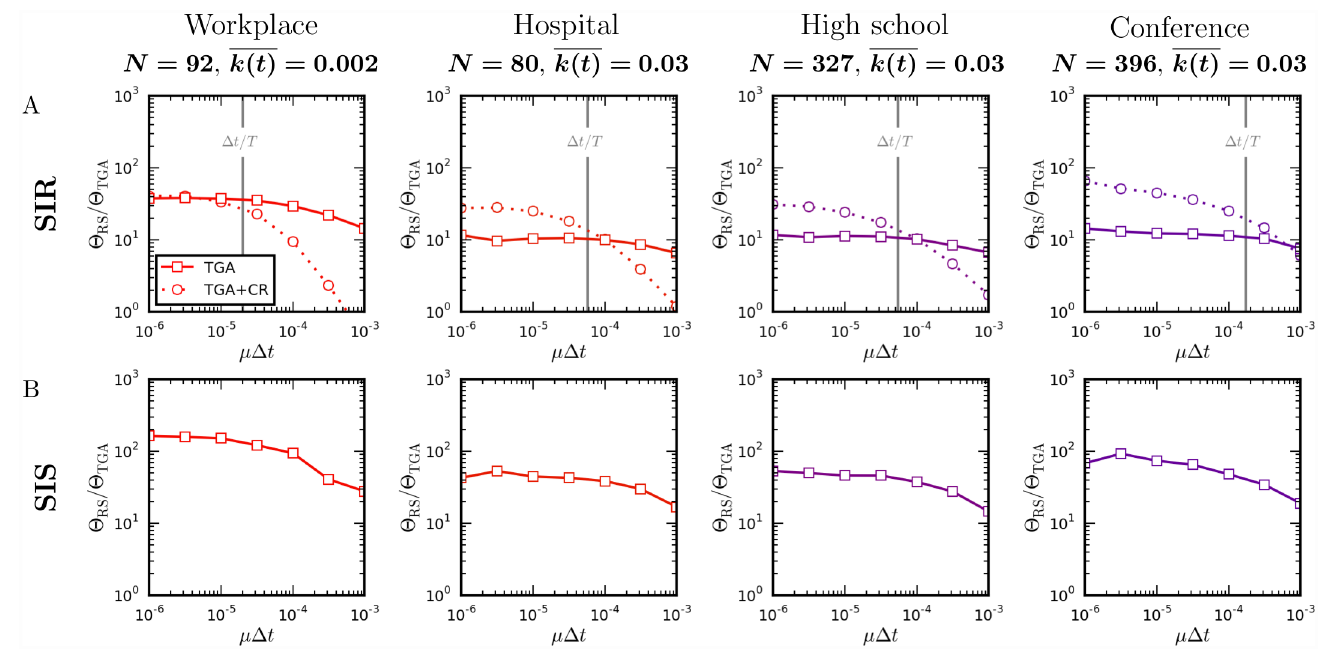
Fig 5. Comparison of the speed of the temporal Gillespie and rejection sampling algorithms on empirical time-varying networks. Ratio Θ RS / Θ TGA between the time per realization of a single simulation using rejection sampling and the temporal Gillespie algorithm on empirical face-to-face contact networks in different social settings (Table 1): (A) for a SIR process, without (TGA) and with (TGA + CR) contact removal; (B) for a SIS process. Simulations were performed with β = 1 000 μ for the workplace and β = 100 μ for the other networks. (Details on how simulations were performed are found in Methods.)